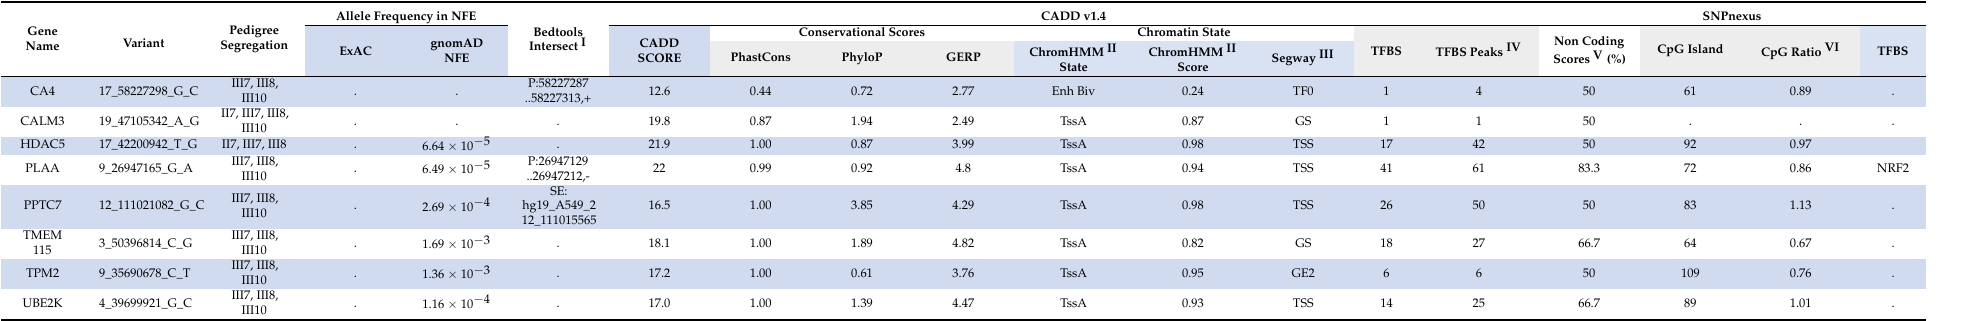
Table 2. 5 (cid:48) UTR germline variants prioritized in the CRC family. Chromosomal position, pedigree segregation and allele frequencies in the non-Finnish European population ( NFE ), accessed on 28 March 2019, are listed for each variant. Promoters, enhancers, super-enhancers identified with Bedtools intersect function and SEA, FANTOM5 databases on 6 April 2019 are included. Overall deleteriousness, genomic conservation, chromatin state and location within transcription factor binding sites (TFBS) are annotated by CADD v1.4 on 30 March 2019. Further information on TFBS, CpG islands and the general functional impact in form of a summarizing percentage of positive non-coding scores are derived from SNPnexus on 31 March 2019. .—not annotated.